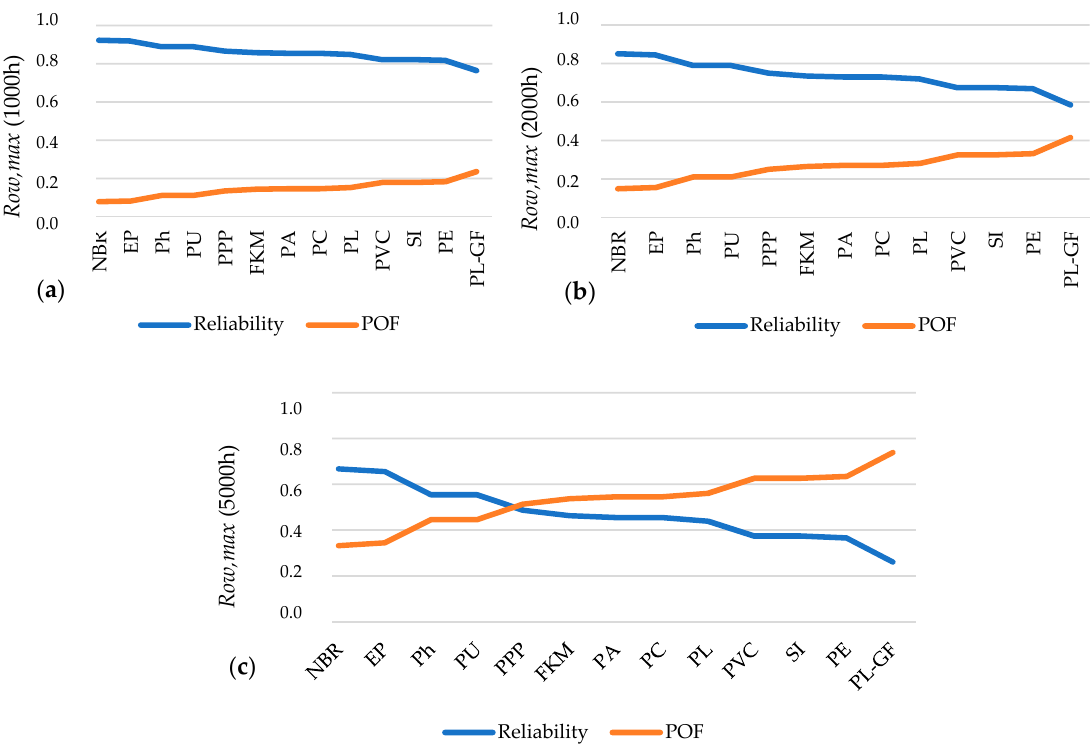
Figure 9. Reliability ( R ) and Probability of Failure ( POF ) for 1000 h ( a ), 2000 h ( b ) and 5000 h ( c ) under the maximum operating window temperature ( T ow,max